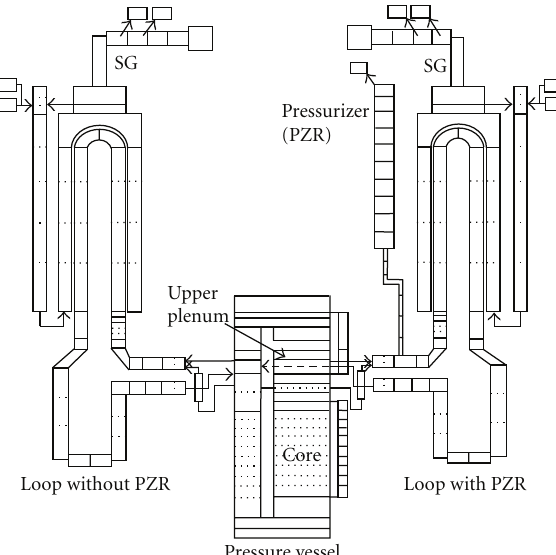
Figure 3: Noding schematic of PWR for RELAP5 analysis.